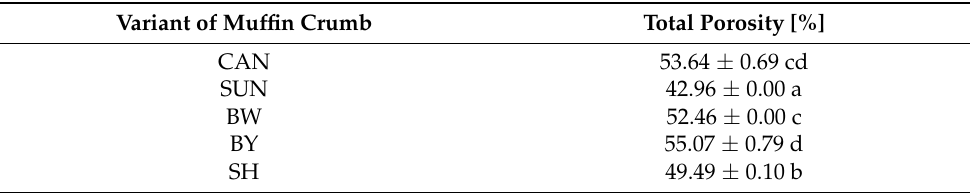
Table 6. Total porosity of muffins crumb